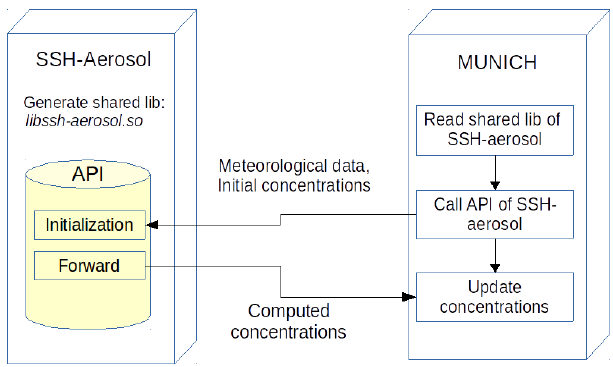
Figure 3. Schematic diagram of the coupling of SSH-aerosol with MUNICH using the